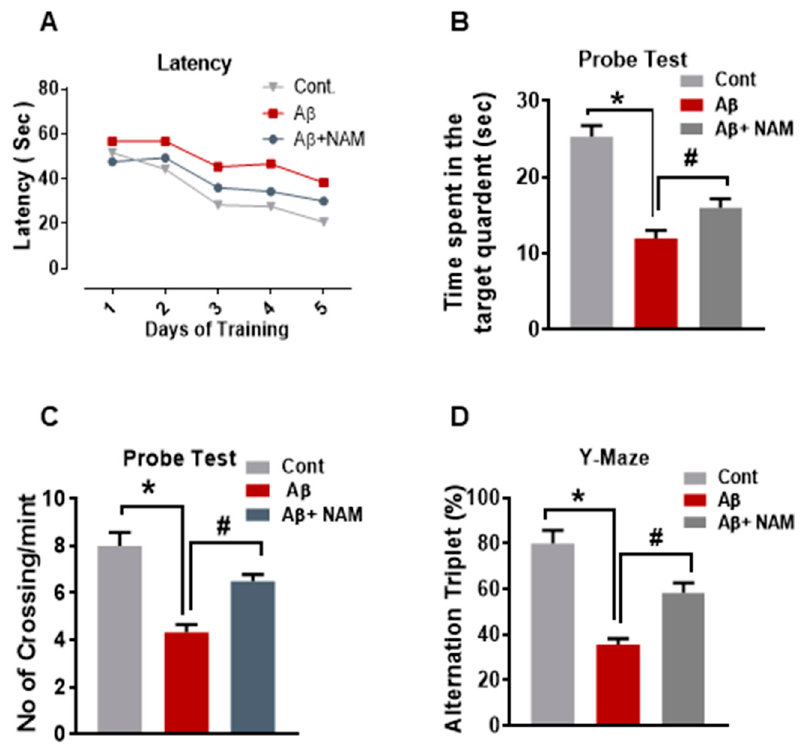
Figure 5. NAM treatment Improved Memory Deficits in hippocampus and cortex of A ꞵ 1–42 injected mice brain.( A) MWM test, where the latency to find the hidden platform was reduced in NAM+ A β 1–42 treatment group compared to A β 1–42 -injected mouse group. ( B ) Probe test, the time spent in the target quadrant was increased in NAM+ A β 1–42 treatment group compared with the A β 1–42 - injected mouse group . ( C ) Number of platform crossings was increased in NAM+ A β 1–42 treatment group compared with the A β 1–42 -injected mouse group( D ) Y-maze test to evaluate spatial working memory. A higher percentage (%) of spontaneous-alteration behavior was considered to be an indication of increased cognitive performance. Compared to the A β 1–42 -injected mouse group, NAM+ A β 1–42 treatment showed a significant increase in spontaneous-alteration behavior.8 animals were kept per group. Asterisk sign (*) indicated significant difference between control and A β injection group; hash sign (#) indicated significant difference between A β injection group and A β + NAM treated group. Significance: (*) # = p ≤ 0.05,.